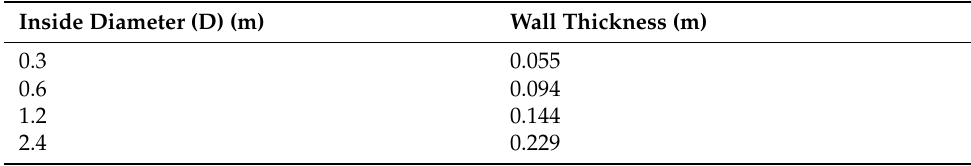
Table 1. The inside diameter of the pipes used in the